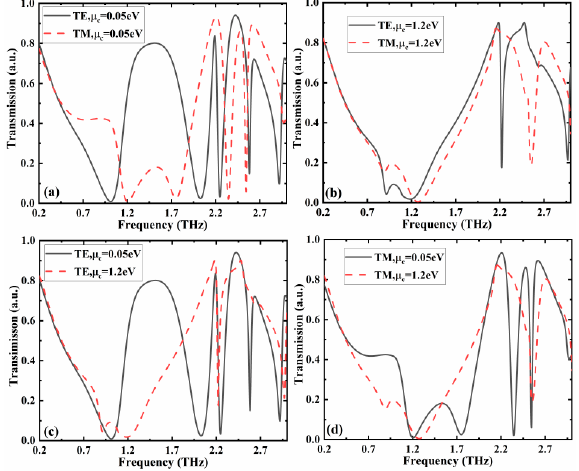
Figure 7. Transmission characteristics of the designed metamaterial structure when the conductivity of VO 2 is 10 S/m and polarization angle of incident wave is 45°. Transmissions of TE- and TM-polarized incident wave when µ c is ( a ) 0.05 eV and ( b ) 1.2 eV. Transmissions of ( c ) TE- and ( d ) TM- polarized incident wave when µ c are 0.05 and 1.2 eV.